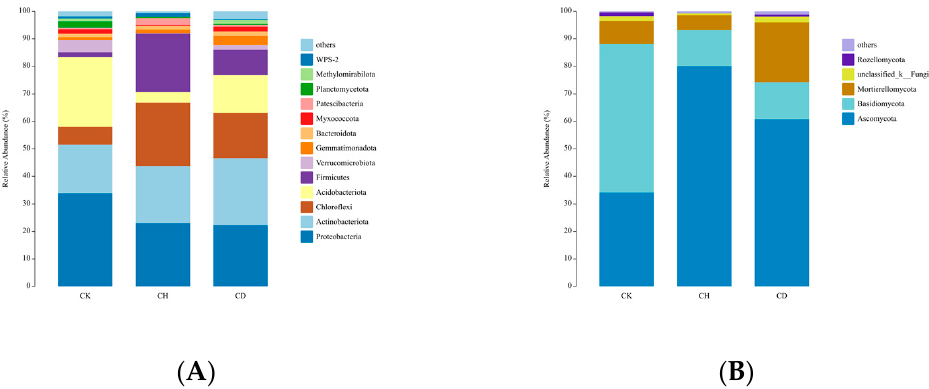
Figure 5. Bacterial and fungal compositions and community structures in the three soil samples. ( A ) Bar plot of the bacterial community at the phylum level. ( B ) Bar plot of the fungal community at the phylum level. The relative abundance in each sample was calculated on the basis of the percentage of the total effective sequences, which were classified using the RDP classifier and compared with the Silva database and the UNITE gene database. Phyla with relative abundances less than 1% were classified as ‘other’. CH—biennial ginseng seedlings that were transplanted and then continuously cropped for four years in healthy ginseng rhizosphere woodland soil, CD—biennial ginseng seedlings that were transplanted and then continuously cropped for four years with severe soilborne disease in ginseng rhizosphere woodland soil, CK—soil sample from woodland without ginseng planting. The relative abundances of Proteobacteria and Acidobacteriota in CH and CD were significantly lower ( p < 0.05) than those of CK, while the relative abundances of Acti- nobacteriota, Chloroflexi, and Firmicutes were significantly higher ( p < 0.05) than those of CK. At the bacterial-phylum level, the relative abundances of Chloroflexi and Firmicutes changed